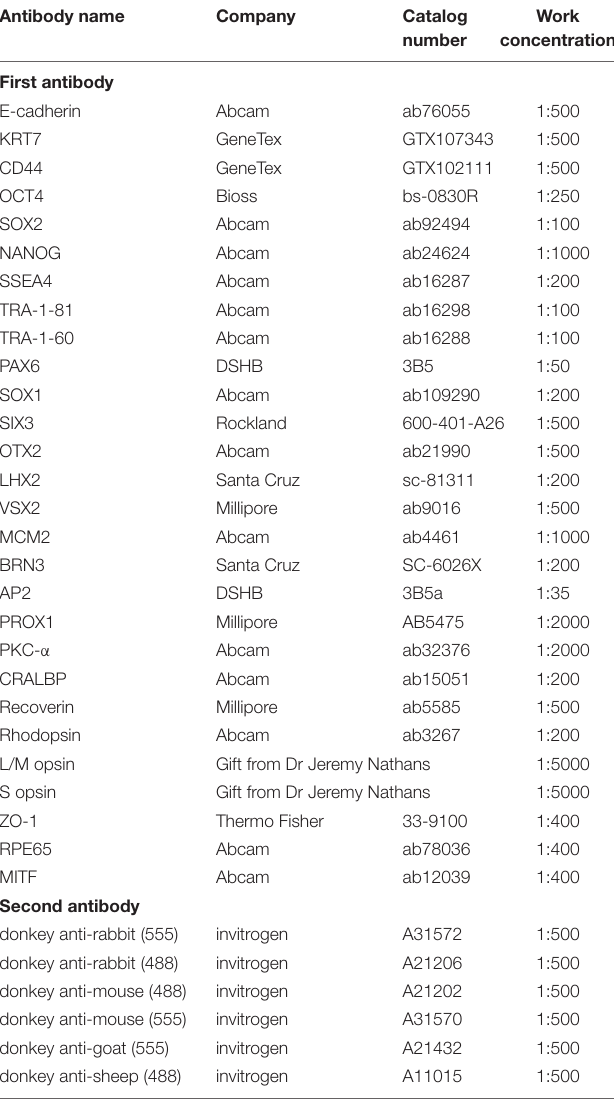
TABLE 1 | List of antibodies used for immunofluorescence